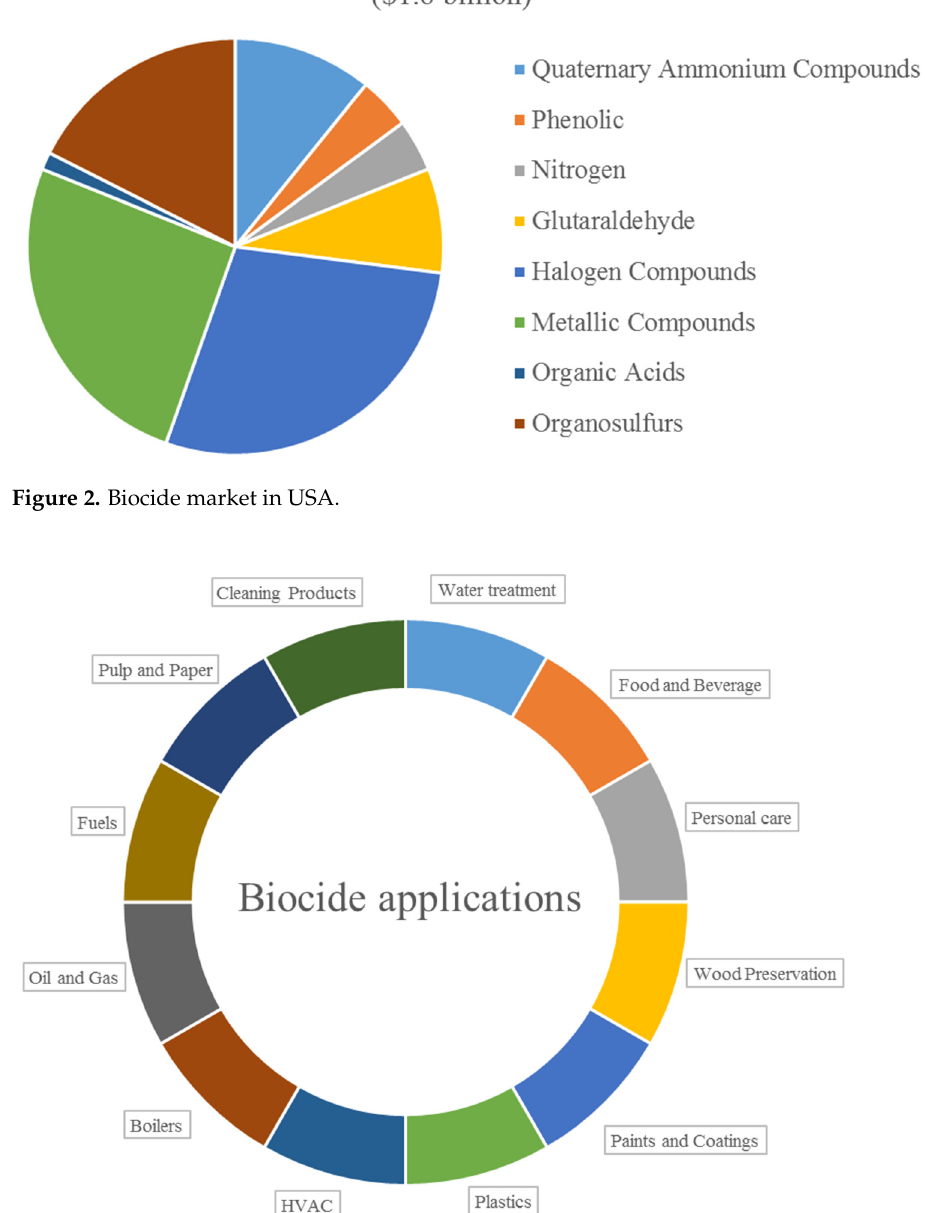
Figure 2. Biocide market in USA.